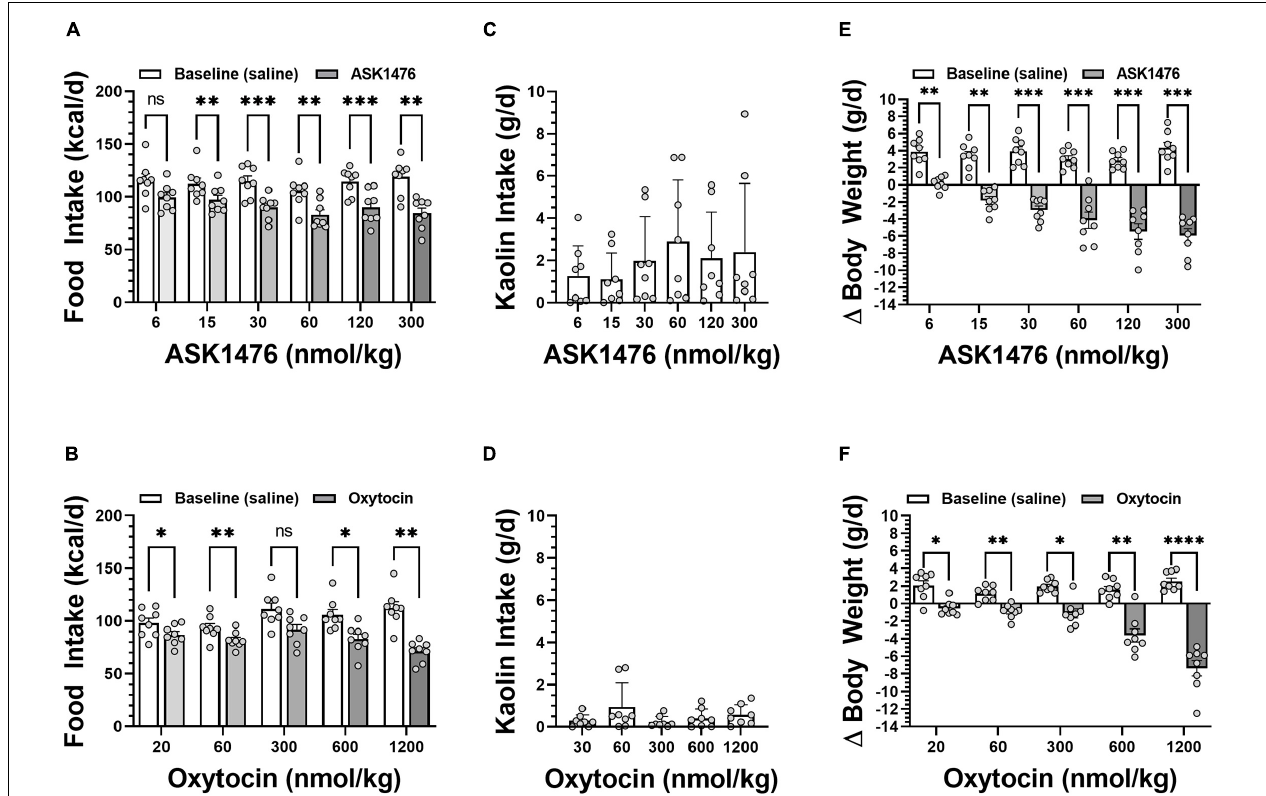
FIGURE 4 | Dose effect of both analog ASK1476 (A) and native oxytocin (OXT) (B) on food intake, kaolin intake, and body weight in DIO rats. ASK1476 showed a comparable reduction of food intake following injection of 30 to 600 nmol/kg of oxytocin demonstrating stronger potency. While kaolin intake, a marker for nausea and visceral malaise induction in rats, seems to exhibit and increasing trend with increasing ASK doses, there was no significant effect of treatment for either ASK1476 (C) or OXT (D) . Both ASK1476 (E) and OXT (F) were effective in reducing body weight gain across the dose spectrum. Post hoc analyses with p -values adjusted for multiple comparisons: ∗ p < 0.05; ∗∗ p < 0.01; ∗∗∗ p < 0.001; ∗∗∗∗ p < 0.0001.